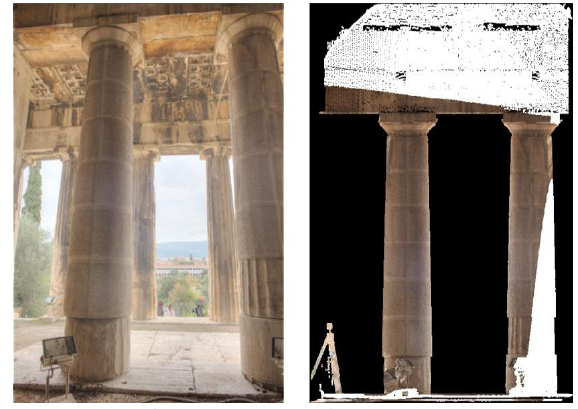
Figure 11: Left: Oblique image of the east interior entrance that used in the algorithm. Right: The produced orthophoto